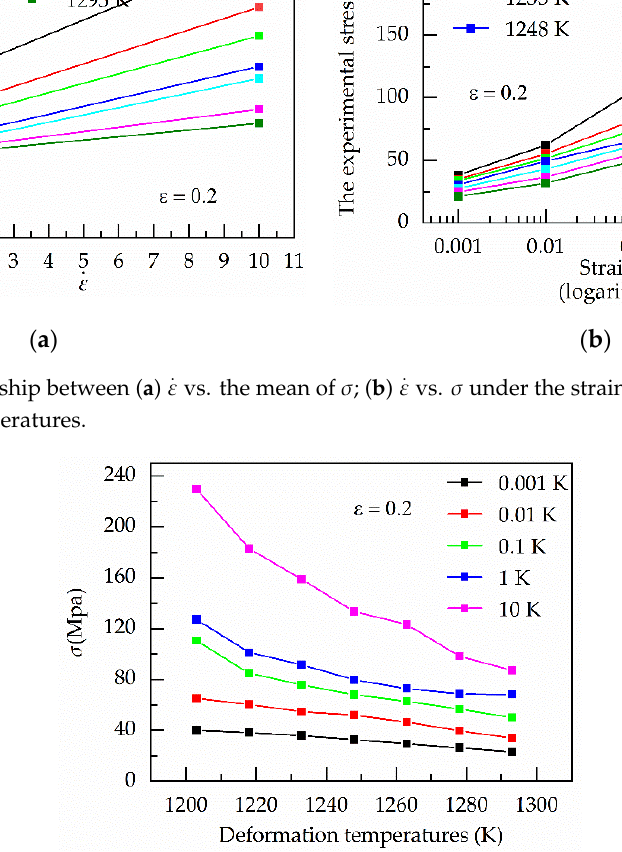
Figure 2. Relationship between deformation temperatures and stress under the strain of 0.20 and various strain rates.